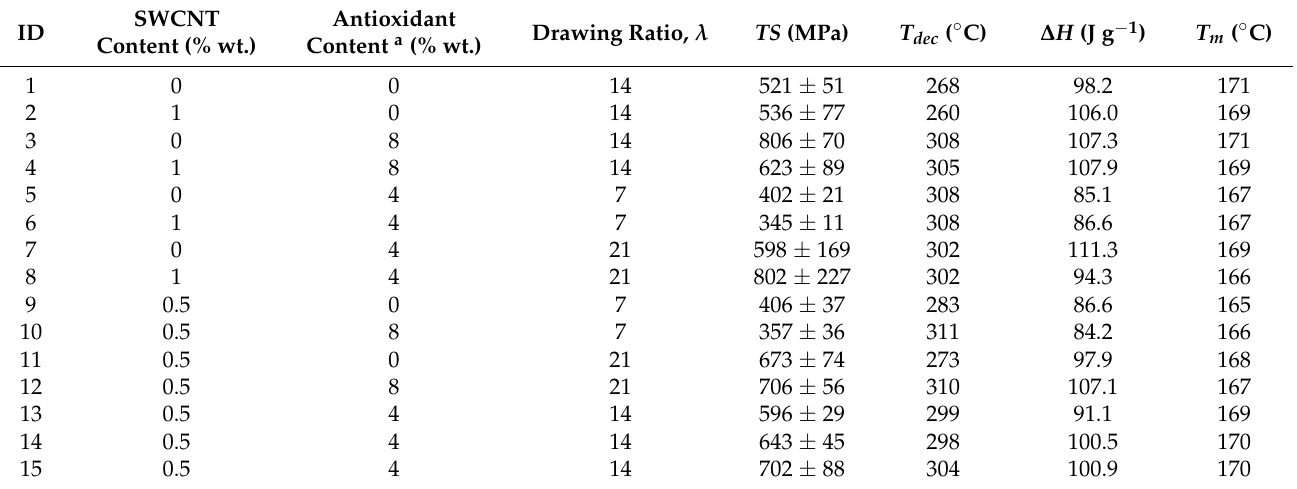
Table 5. DoE2 results (composites with